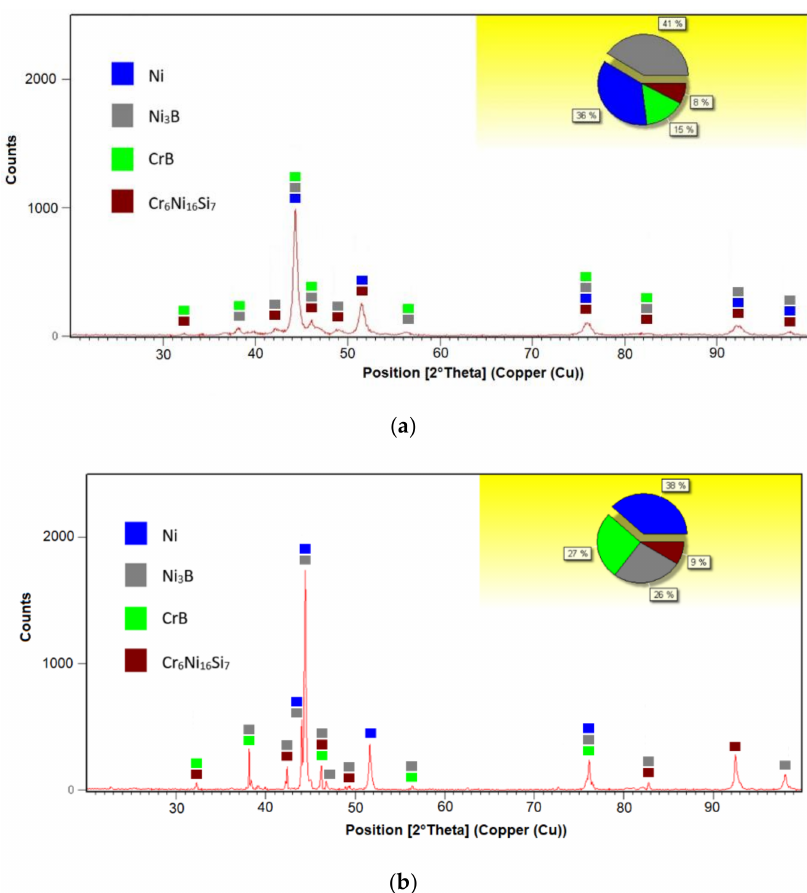
Figure 7. XRD spectra of the FR ( a ) and VR ( b )